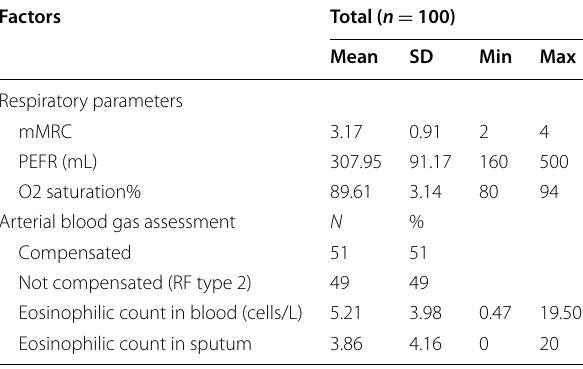
Table 2 Eosinophilic count in blood and sputum and respiratory parameter assessment of patients